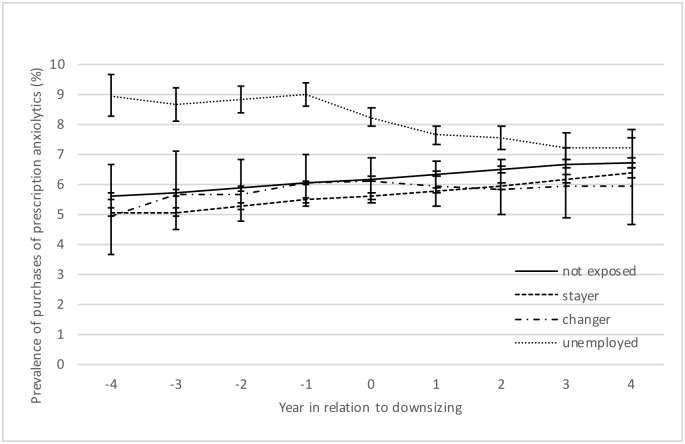
Prevalence of purchased prescribed anxiolytics by employment status (%).Adjusted for sociodemographic factors and previous sickness absence history, with 95% CI.